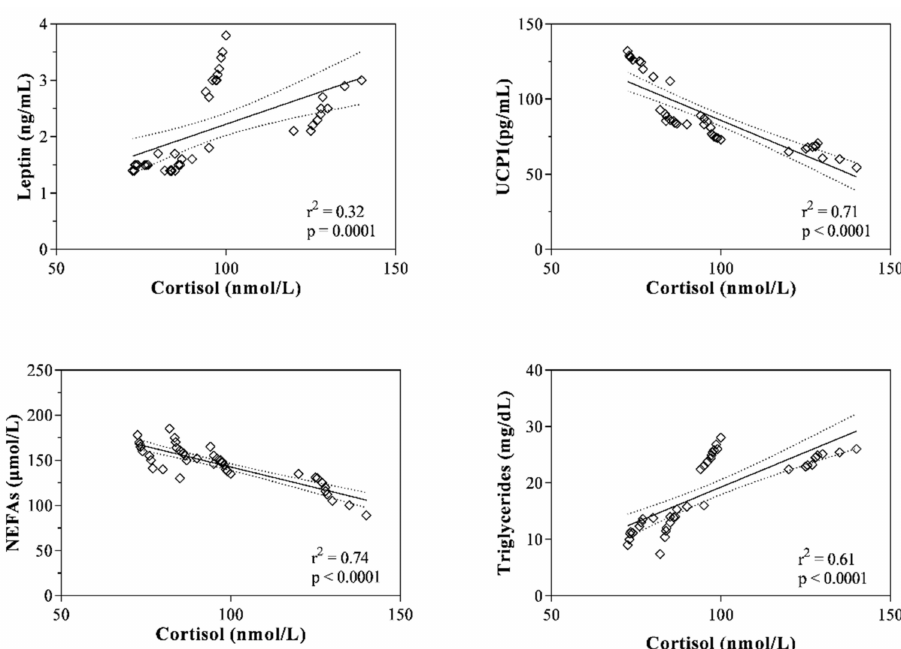
Figure 4. Linear regression values between the serum cortisol concentration and the levels of serum parameters were statistically correlated in pregnant mares (Group A) throughout the considered peripartum period (i.e., leptin; mitochondrial uncoupling protein 1, UCP1; non-esterified fatty acids, NEFAs; triglycerides; very low-density lipoprotein